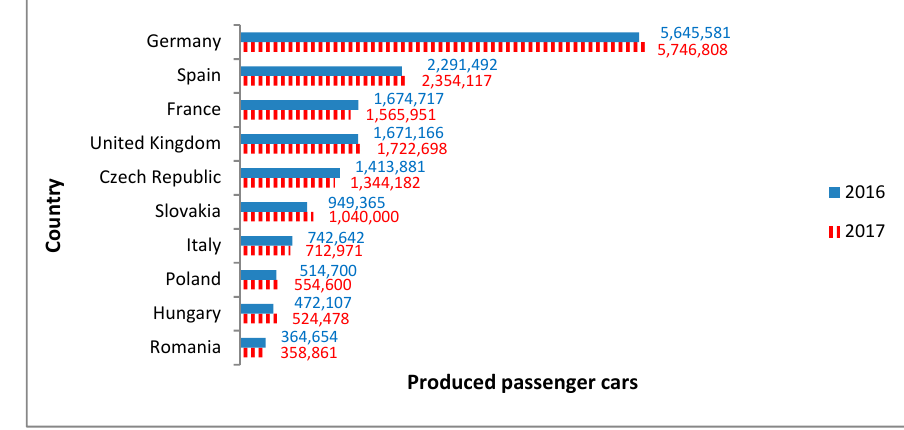
Figure 1. European Union (EU) leading producers of passenger cars (according to [1]).